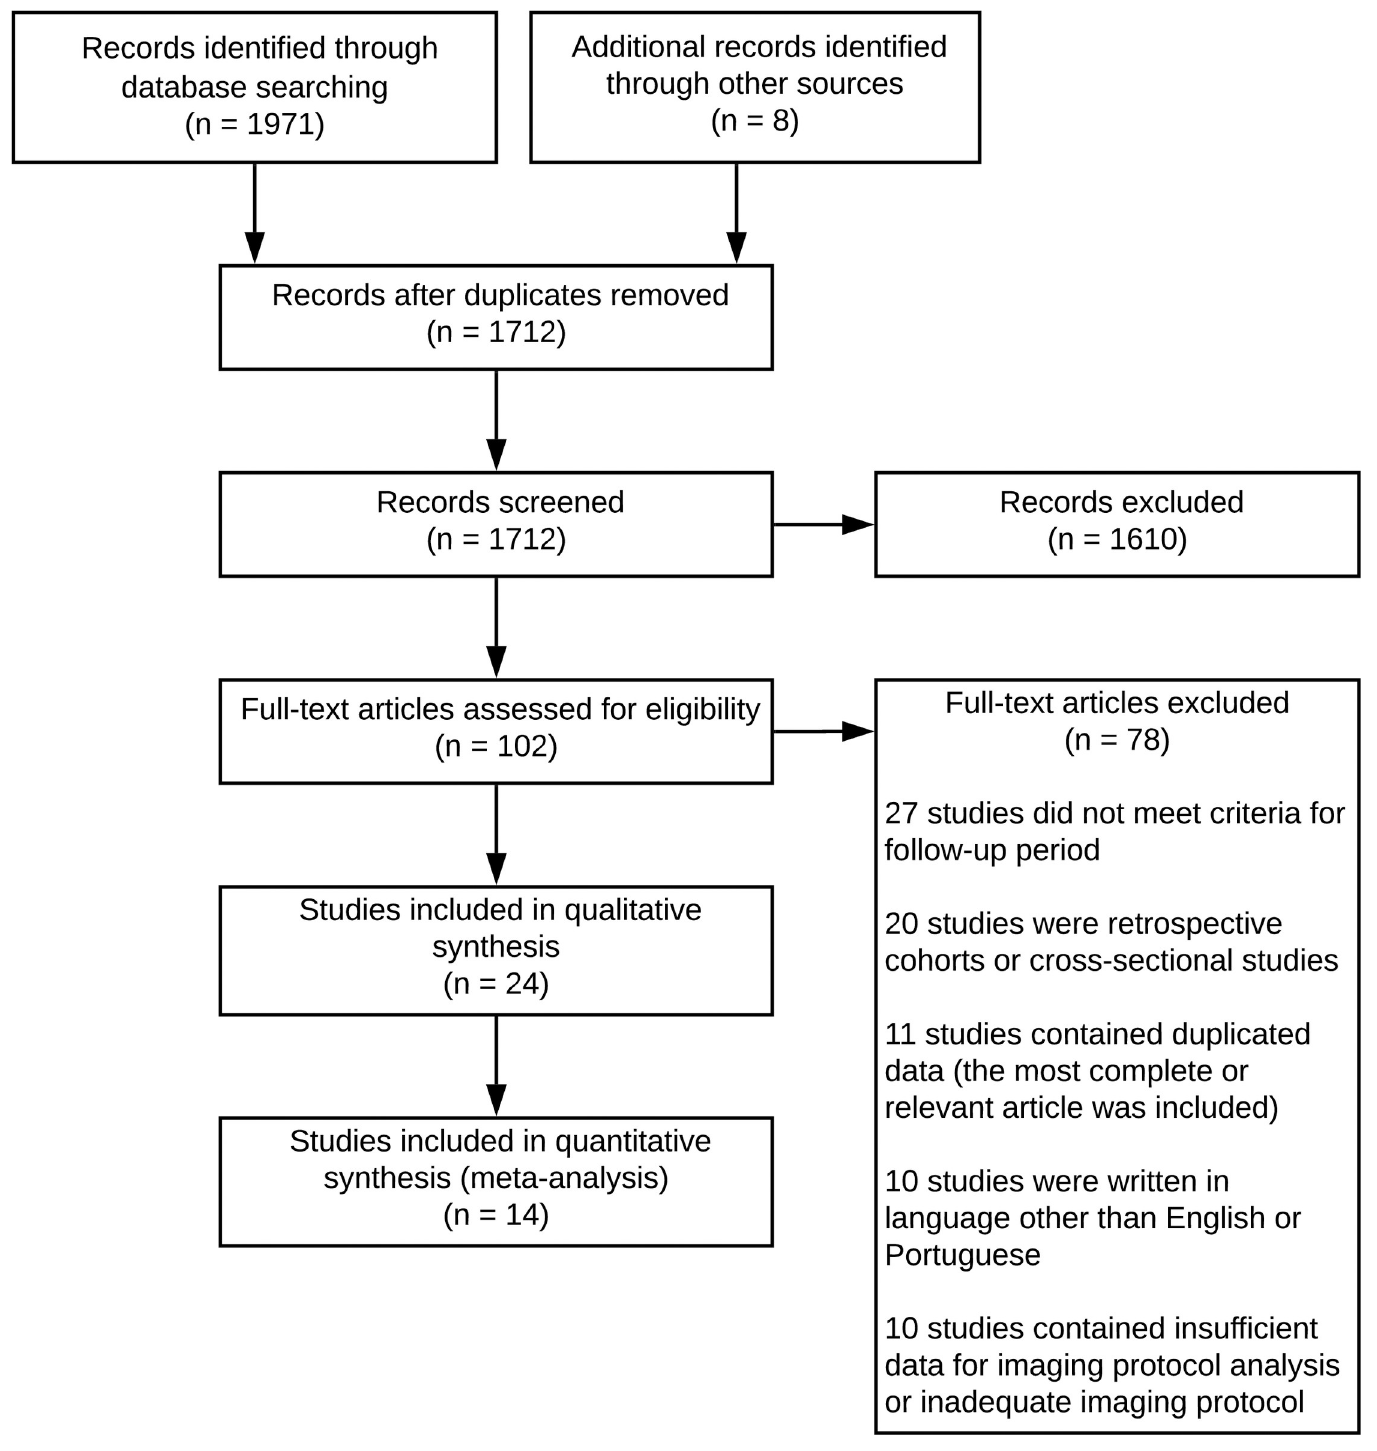
Fig 1. Flowchart of study selection.